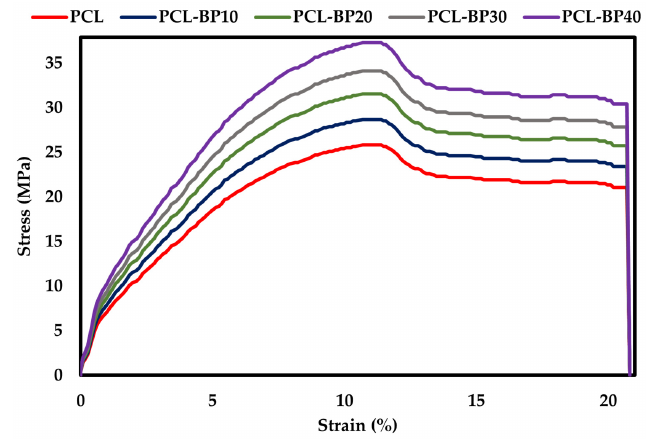
Figure 8. Tensile curve of PCL and PCL-BP